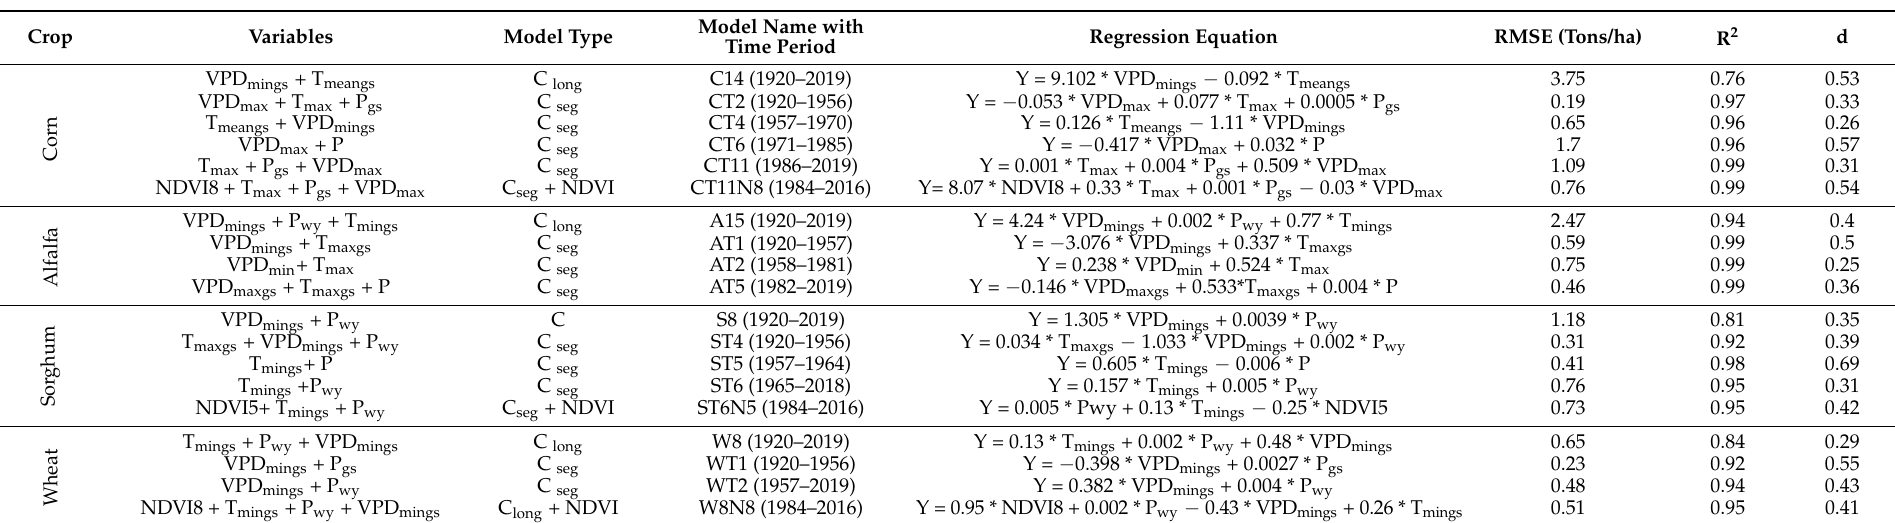
Table 6. Comparison of crop yield prediction models based on climate only, climate and NDVI, and segmented data